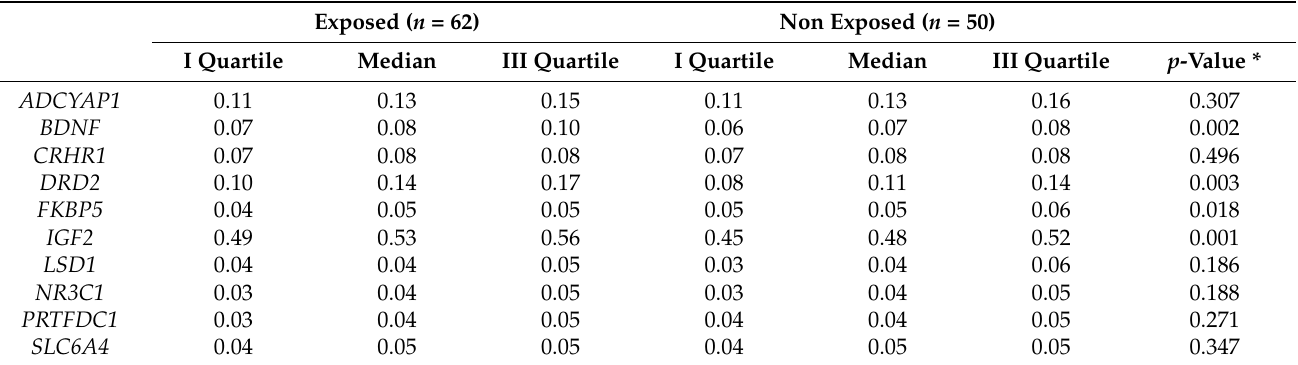
Table 3. Distribution (median and interquartile range) of DNA methylation of 10 genes among 62 trauma-exposed women and 50 trauma-free controls. Exposed ( n = 62) Non Exposed ( n =